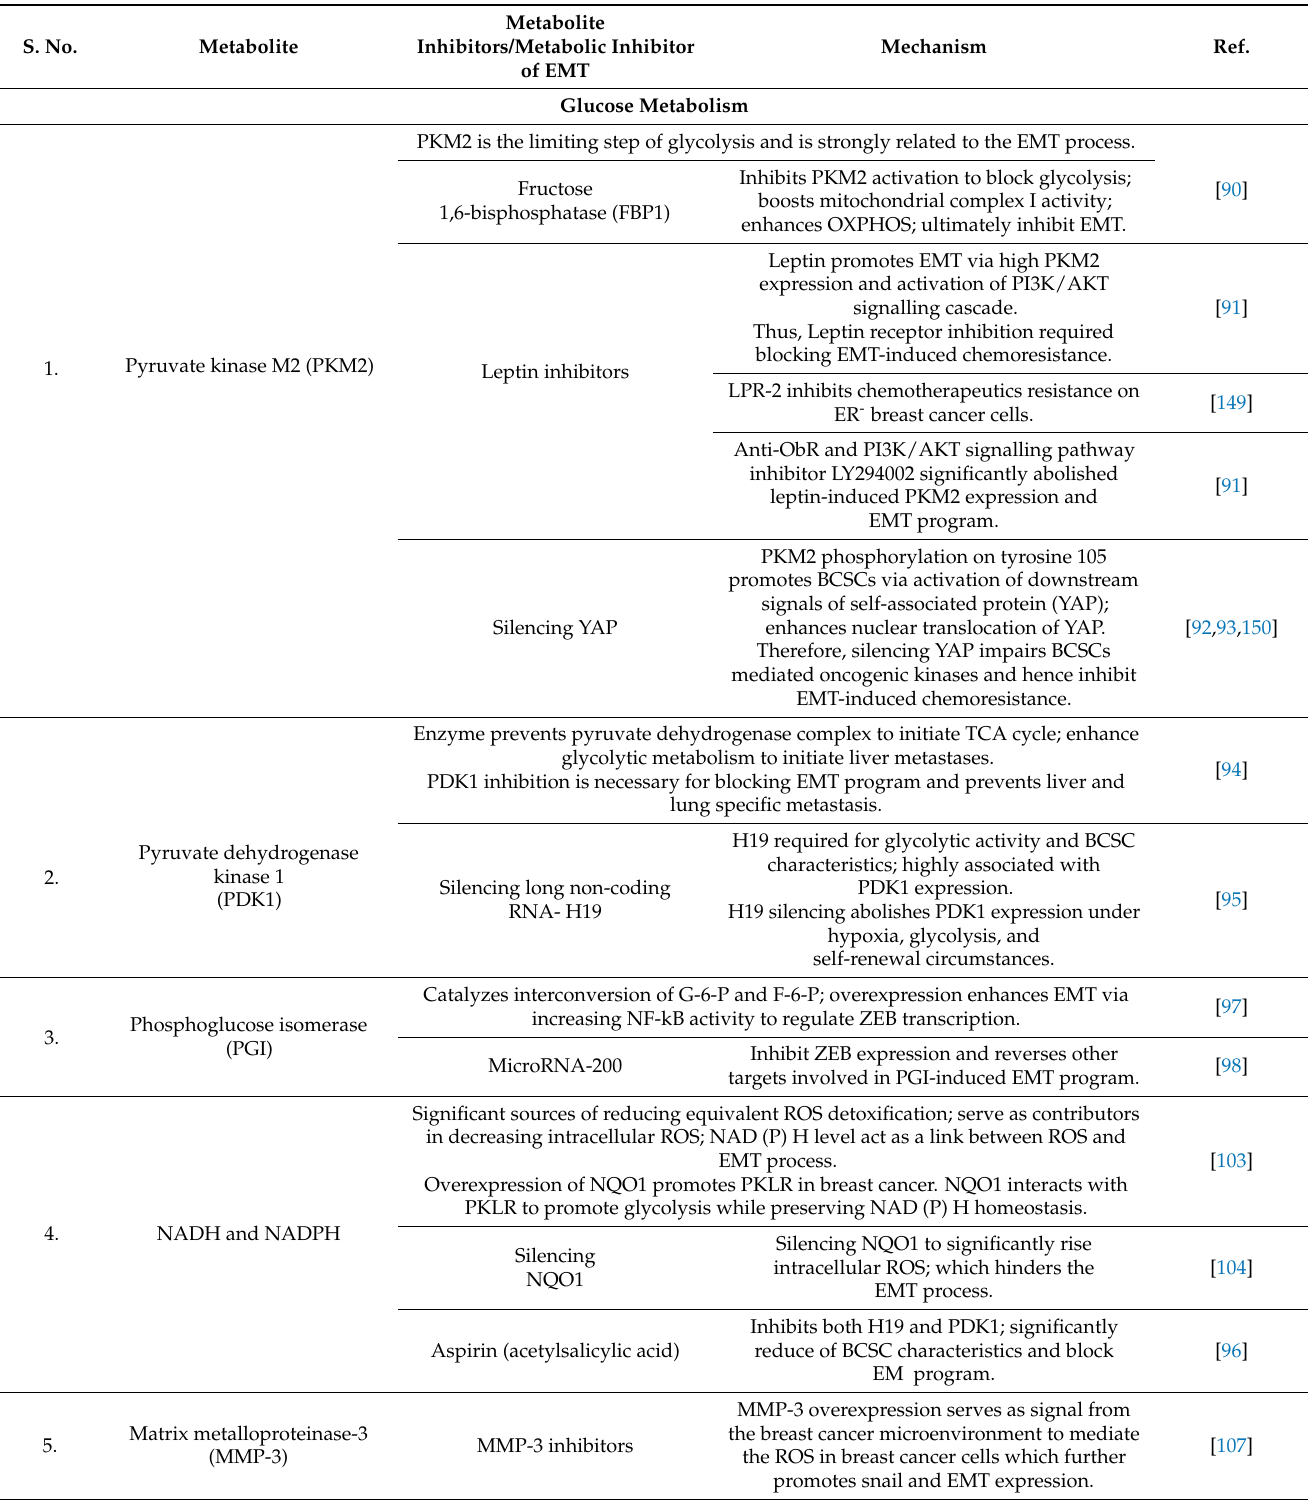
Table 3. Different metabolites along with metabolic inhibitors to retard EMT program of breast